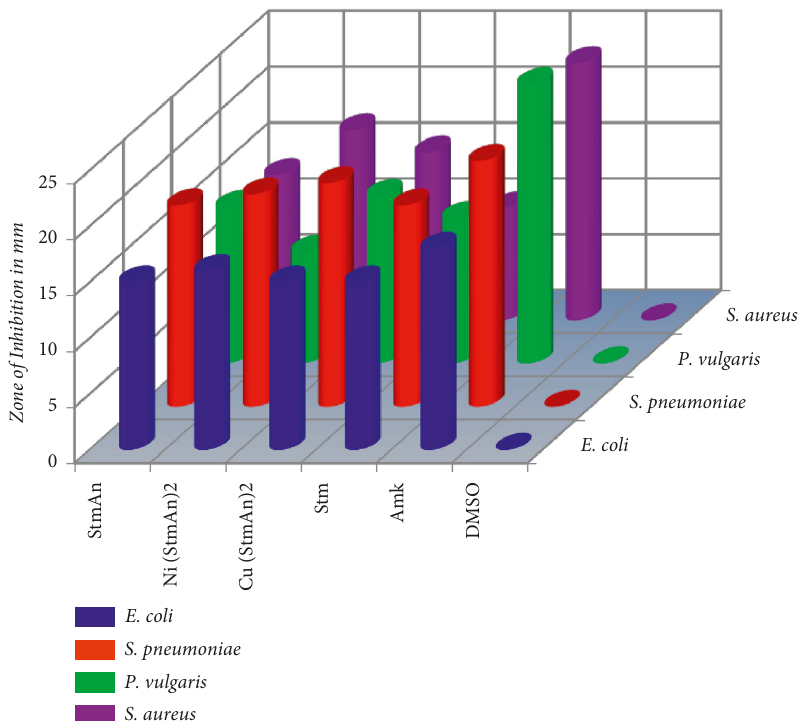
Figure 7: Bar graph showing the antibacterial activity at 50 μ g/ μ L concentration.